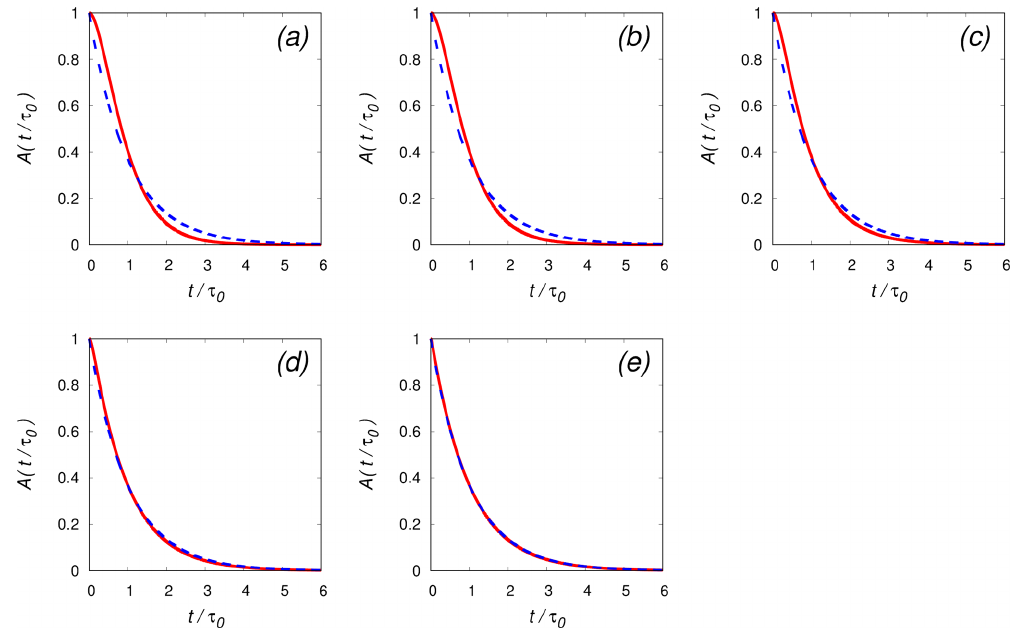
Figure 4. Auto-correlation functions in the statistically steady state for the simplified model ( B(t) in Eq. 35: blue dashed curve) and the second version ( A(t) in Eq. 28: red solid curve). Here, c 1 = c 2 = 1. The parameters for each panel are as follows: (a) L = 10 − 2 m, τ = 0 . 447s, τ 0 = 0 . 844s, Da = 0 . 127; (b) L = 10 − 1 m, τ = 2 . 08s, τ 0 = 3 . 38s, Da = 0 . 591; (c) L = 10 0 m, τ = 9 . 63s, τ 0 = 12 . 2s, Da = 2 . 74; (d) L = 10 1 m, τ = 44 . 7s, τ 0 = 48 . 0s, Da = 12 . 7; and (e) L = 10 2 m, τ = 208s, τ 0 = 211s, Da = 59 . 1. The phase relaxation time is fixed to τ relax = 3 . 513s. The horizontal axis is the time t normalized by the auto-correlation time τ 0 for each case. The parameter τ is determined from the integral length L based on the setting for the numerical experiment described in Appendices A and